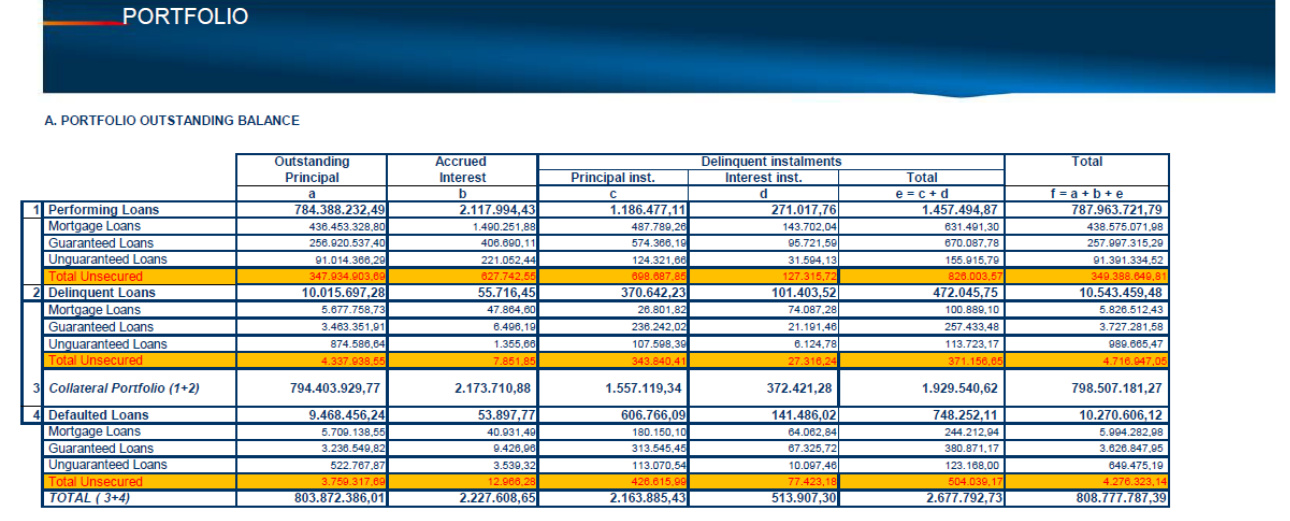
Figure 17. Example of “aggregation report”.